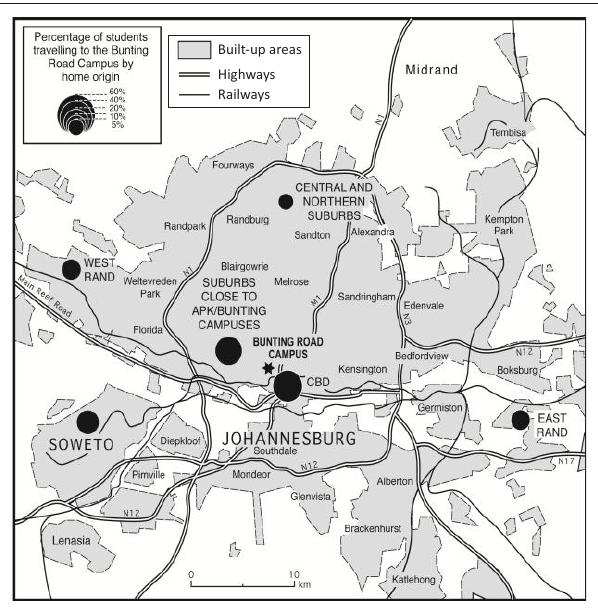
FIGURE 1: Origin of Auckland Park Bunting Road Campus